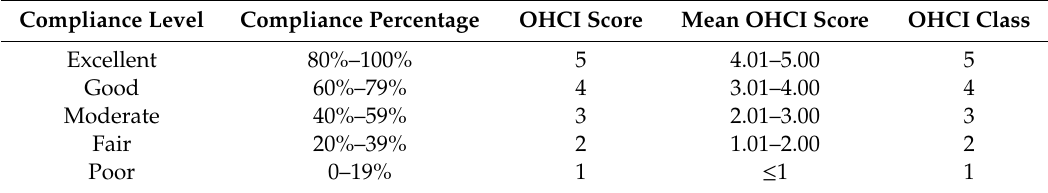
Table 2. Octa hearing conservation index (OHCI) score, mean score, and class for HCP components